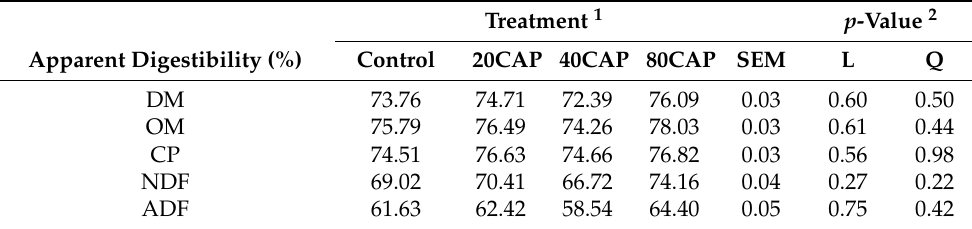
Table 5. Effects of Capsicum oleoresin (CAP) on apparent total tract digestibility of nutrients in heat-stressed dairy